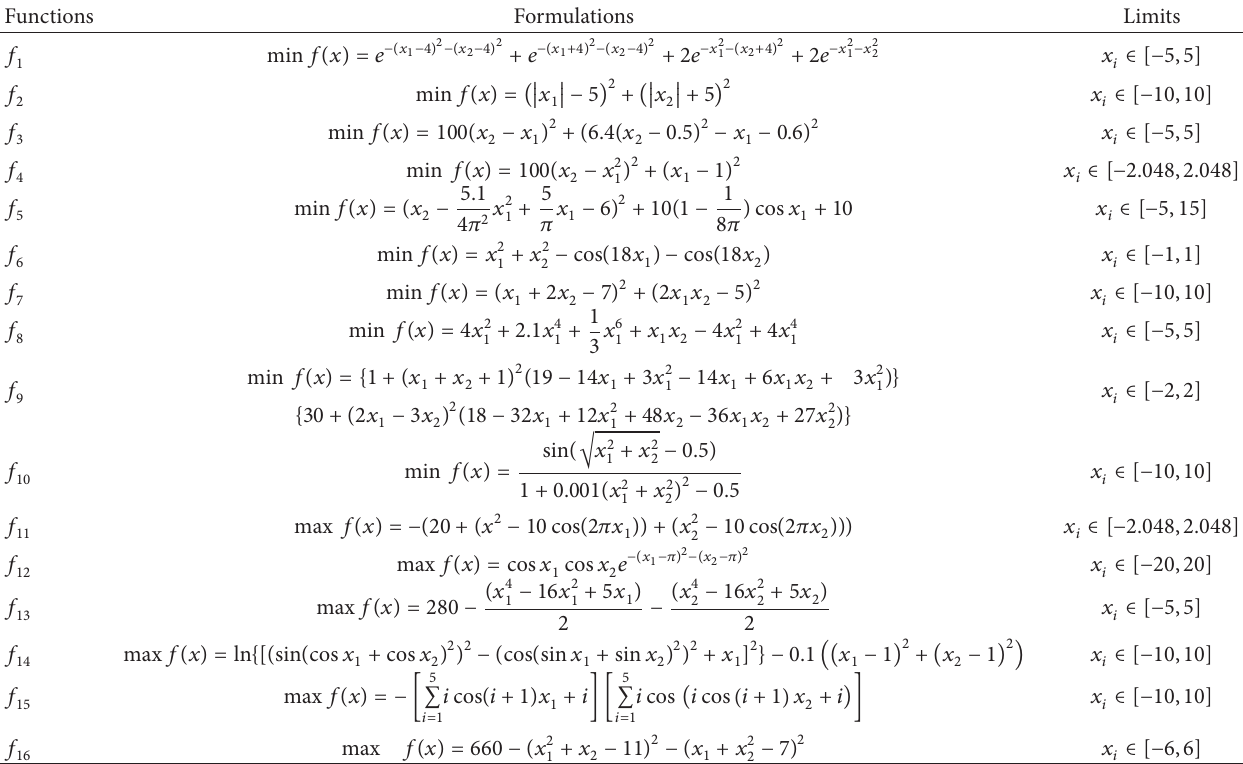
Table 1: Benchmark